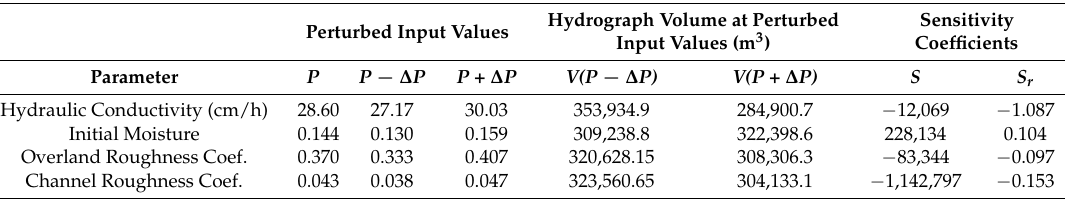
Table 8. Sensitivity analysis for hydrograph water volume at the Demajagua River